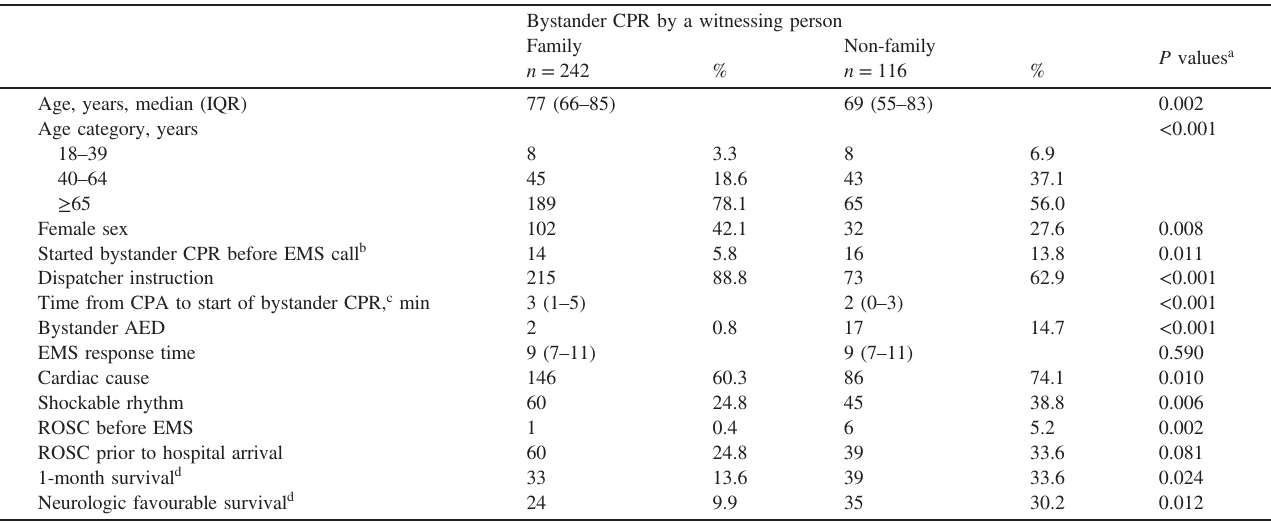
Table 4. Di ff erences between bystander cardiopulmonary resuscitation by family and non-family members among patients who received bystander cardiopulmonary resuscitation performed by a witnessing person Bystander CPR by a witnessing person Family Non-family Age, years, median (IQR)